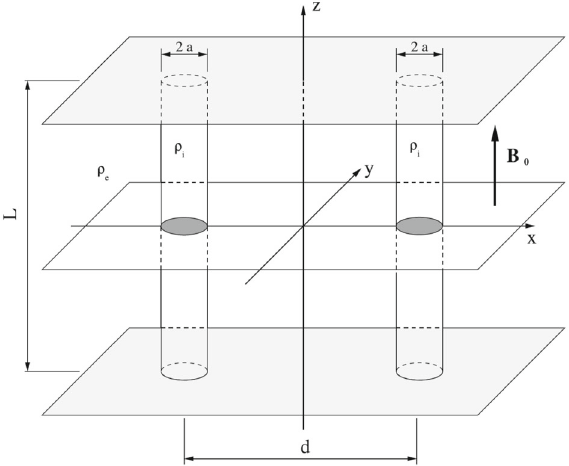
Fig. 46 Sketch of an equilibrium model made of two infinitely long threads embedded in the solar corona. Image reproduced with permission from Luna et al. (2008), copyright by AAS